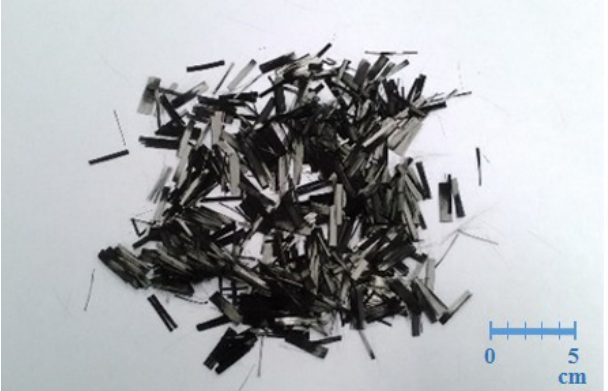
Figure 7. Appearance of carbon fibers.